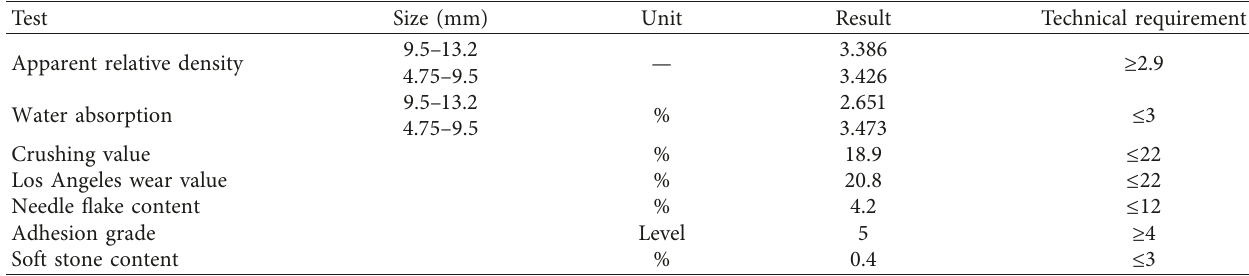
Table 3: Steel slag